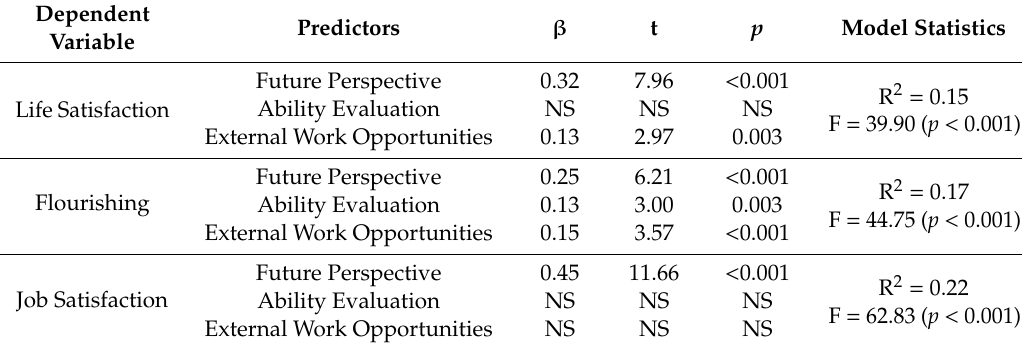
Table 5. Regression of Self-Perceived Employability on Well-being